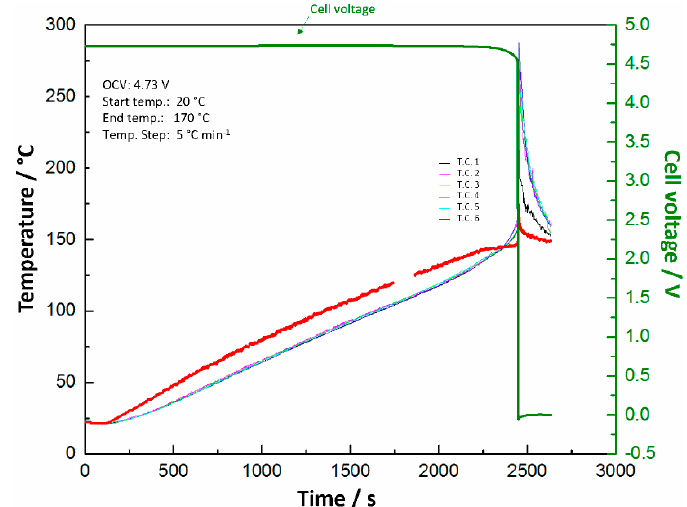
Figure 3. Evolution of the cell temperature and voltage with time during hot box test.